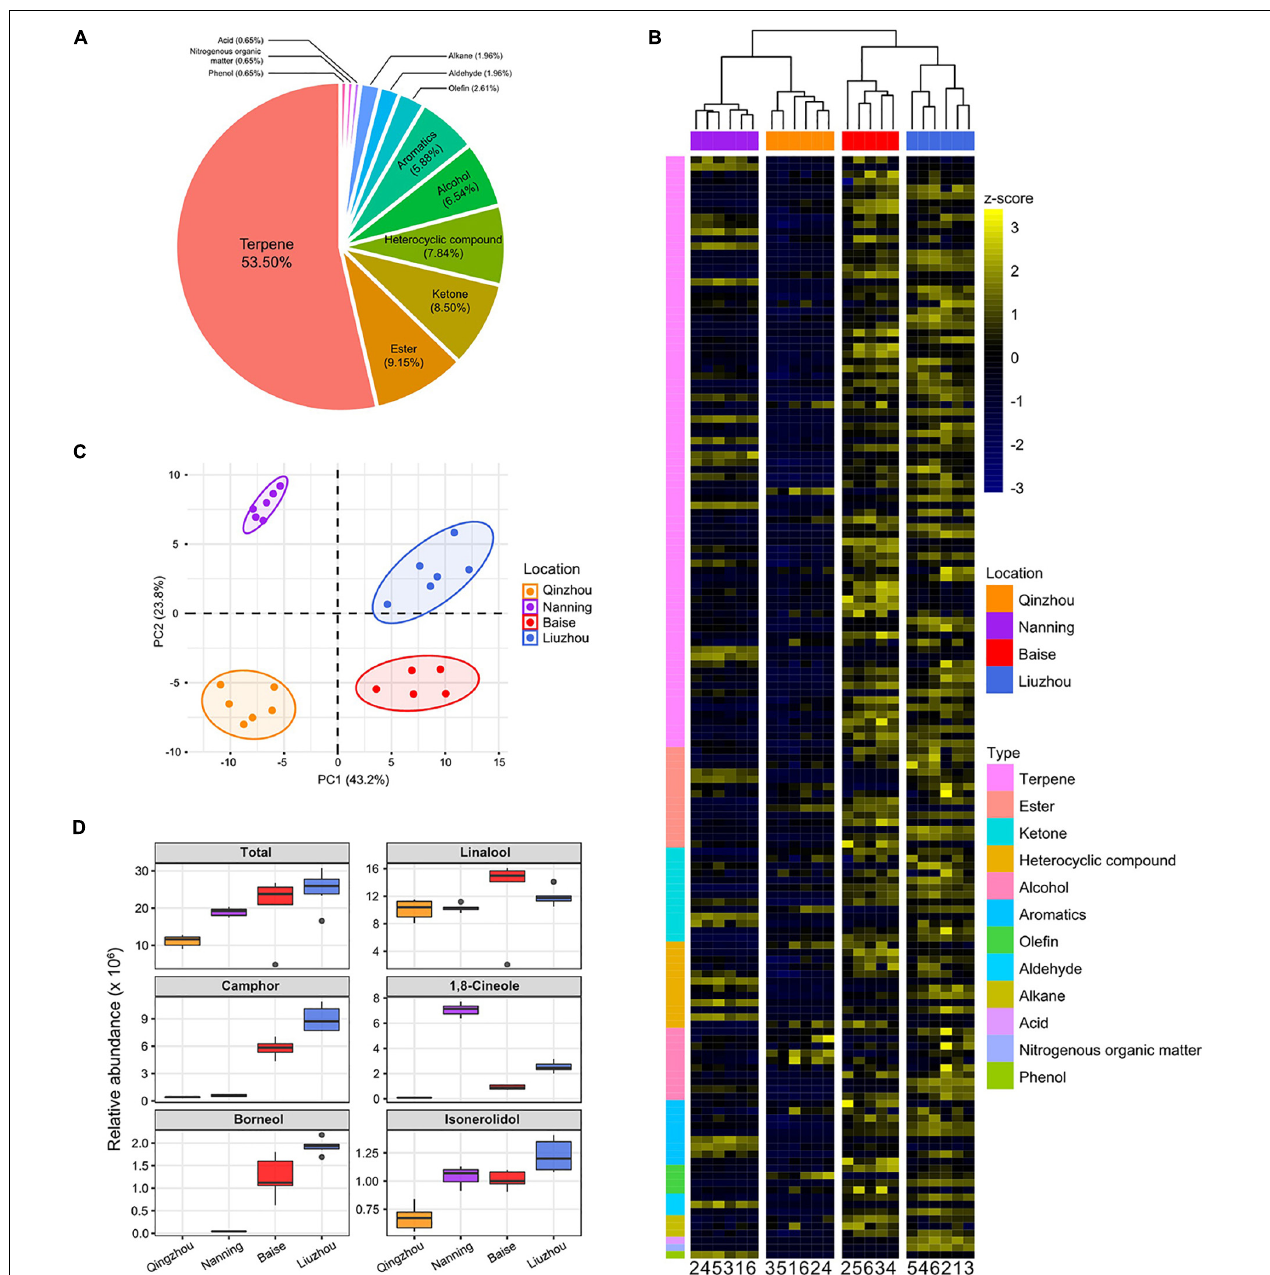
FIGURE 4 | Abundance patterns of volatile metabolites in C. camphora planted in different locations. (A) Pie charts show the proportions of different types of metabolites identified in the current study. (B) Hierarchical clustering heatmap of metabolic abundance profiles in the four planting locations, including Qinzhou, Nanning, Baise and Liuzhou, indicated on the x -axis. Metabolic abundance was averaged and z-score transformed. The rows are clustered by the types of metabolites. (C) Principal component analyses (PCA) of metabolites of C. camphora planted in the four locations. The circles represent the 95% confidence intervals. (D) The relative abundances of linalool, borneol, camphor, 1,8-cineole and isonerolidol in the four planting